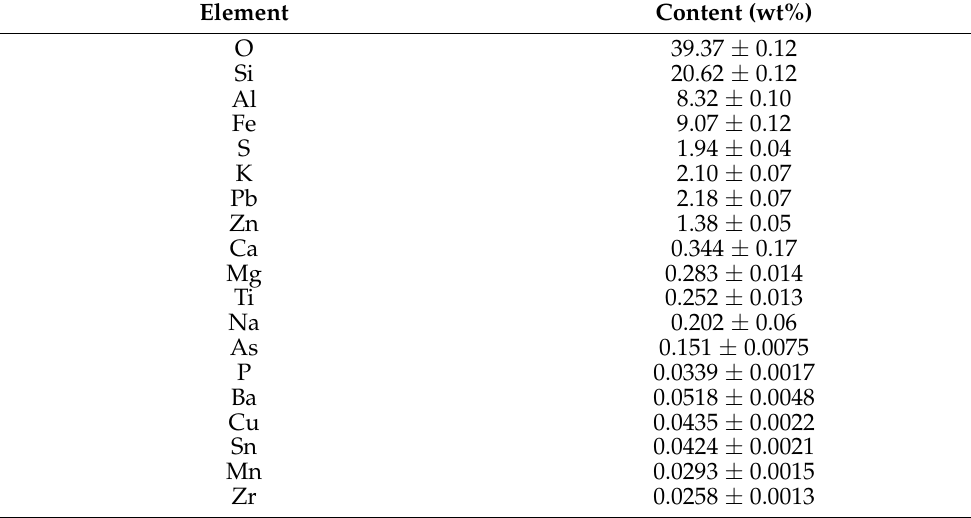
Table 2. Chemical composition of RD